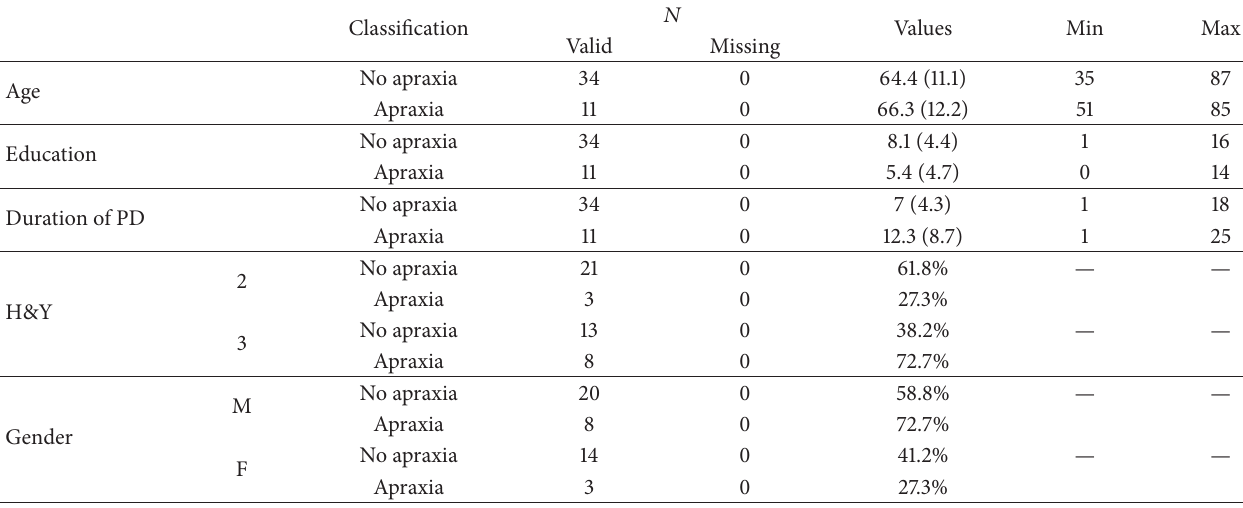
Table 2: Assessment of age, education, duration of disease, PD stage (H&Y), and gender in patients without apraxia or with nonverbal and verbal apraxia.